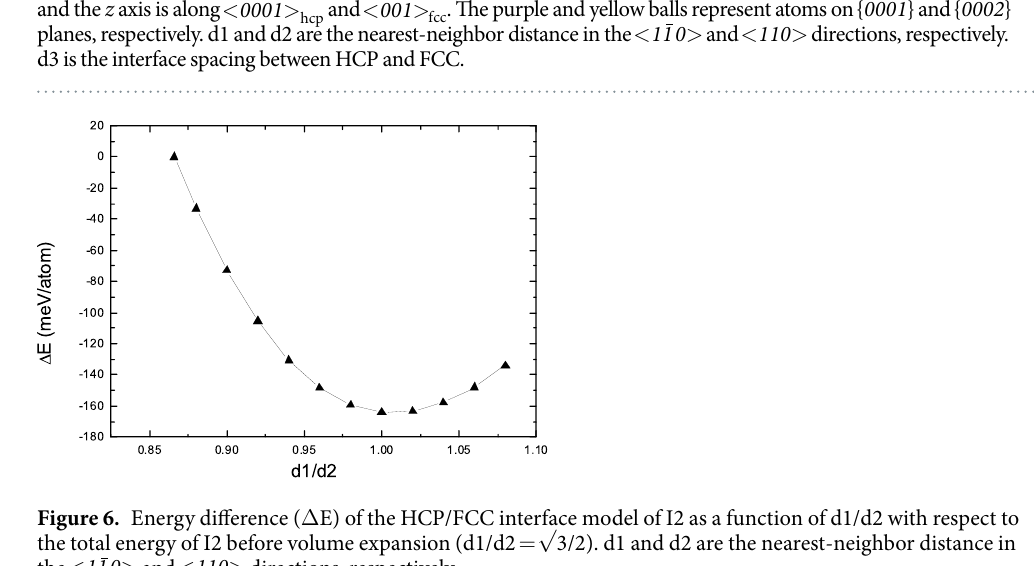
< > and < > 110 and < > 110 , the y axis is along 1210 , fcc fcc hcp hcp and < > 001 . The purple and yellow balls represent atoms on 0001 { } and 0002 { } fcc hcp